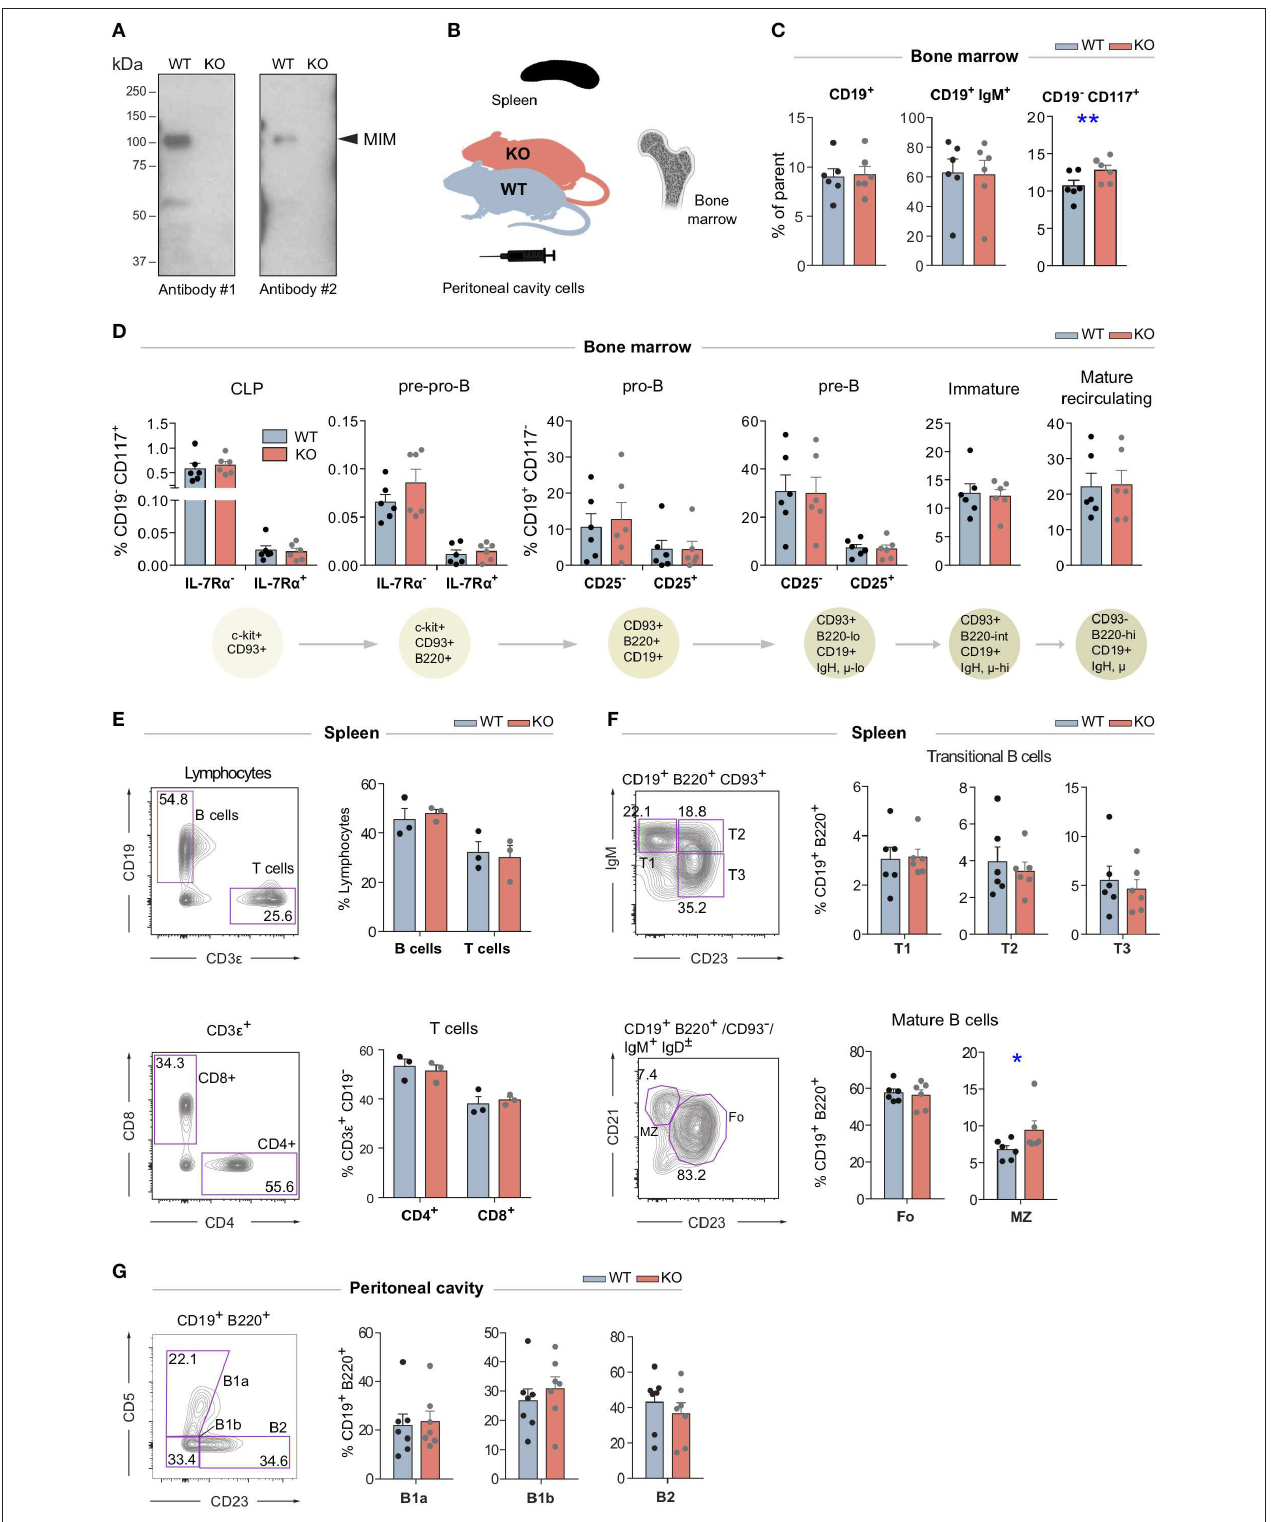
FIGURE 1 | Largely normal B cell development and composition of B cell compartments in the bone marrow, spleen, and peritoneal cavity of MIM − / − mice. (A) Equal numbers of WT and MIM-KO splenic B cells were lysed and analyzed by immunoblotting with MTSS1 antibodies [4385S (Ab #1), 4386S (Ab #2), Cell